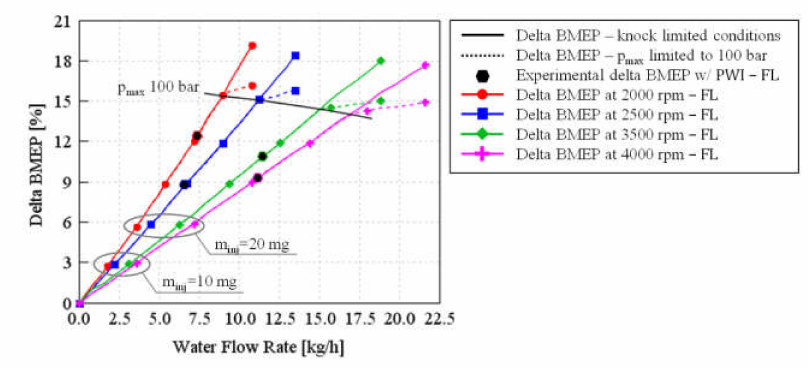
Figure 14. Relative improvement of Brake Mean E ff ective Pressure BMEP enabled by PWI at Full-Load as a function of the injected water flow